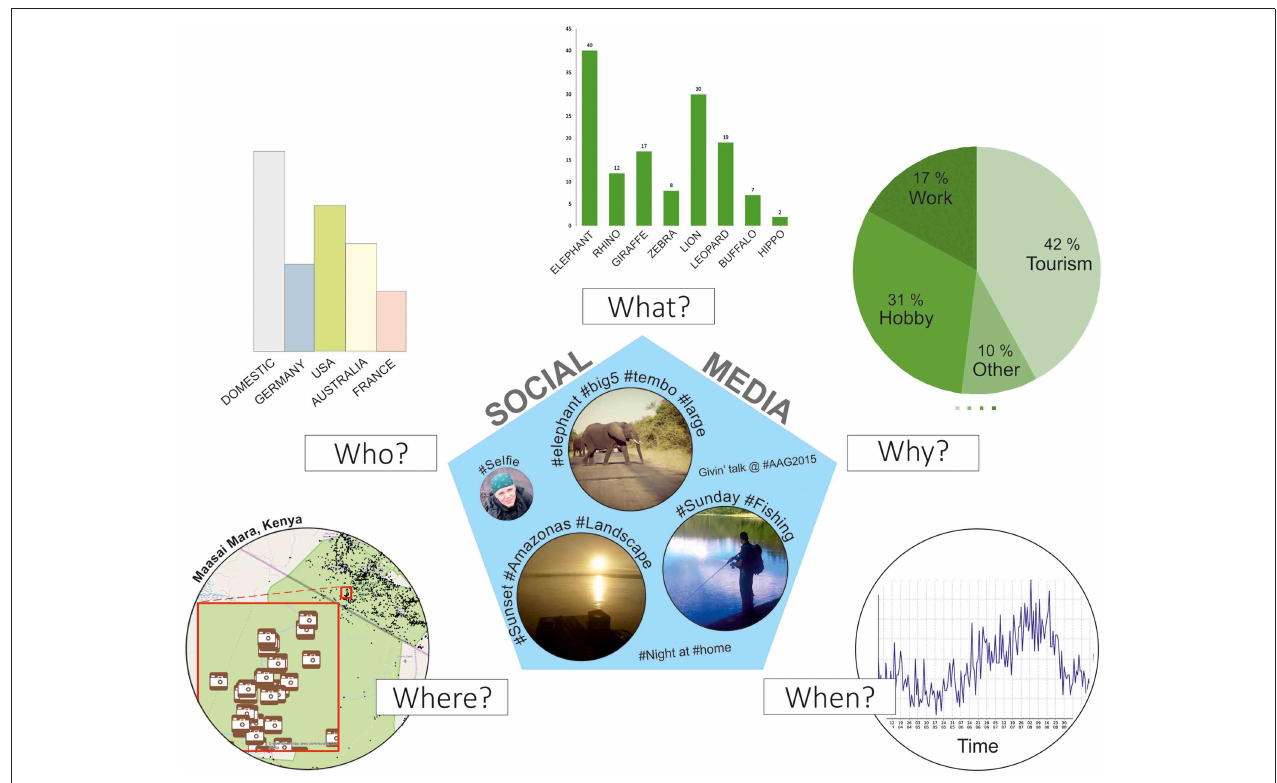
FIGURE 1 | Conceptual framework for the use of social media data in conservation